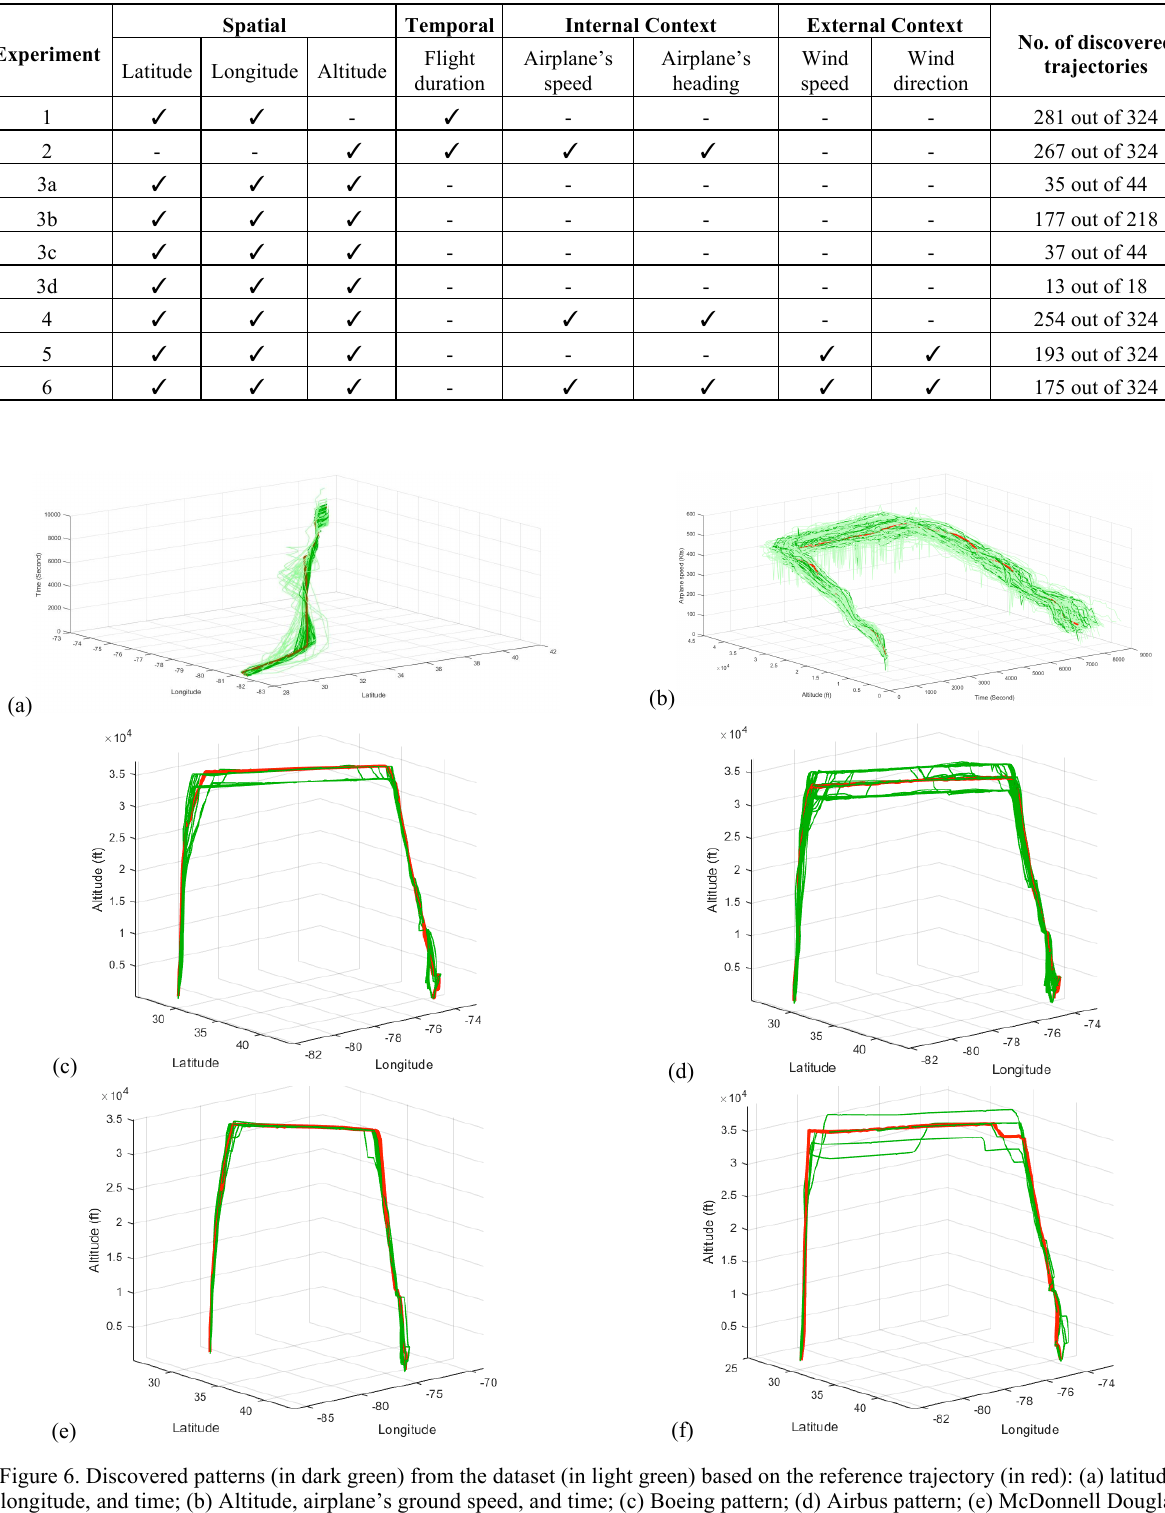
Table 1. Multi-dimensional pattern discovery of trajectories